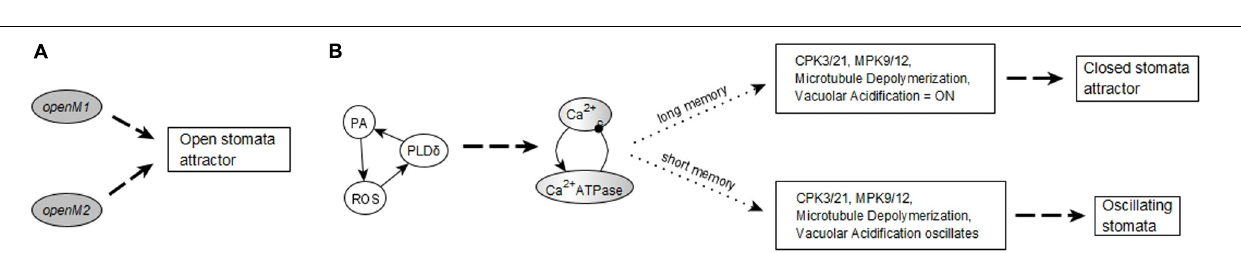
FIGURE 7 | Stomatal re-opening after removal of the signal in the updated Model1. The signal, ABA (vertical lines) is set to fixed ON state for the first 30 time-steps and then set to fixed OFF state for 70 time-steps. The closureM conditionally stable motif (downward triangles) is stabilized within the first 10 time-steps and it slowly destabilizes after ABA is set to the OFF state. The state of the node Closure, depicted by the star symbols, shows a similar behavior i.e., it starts decreasing after the signal is removed. The state of the node Ca 2 + c , depicted by the circle symbols, is oscillating in the presence of ABA and it slowly transitions to the OFF state after ABA is fixed to OFF state.